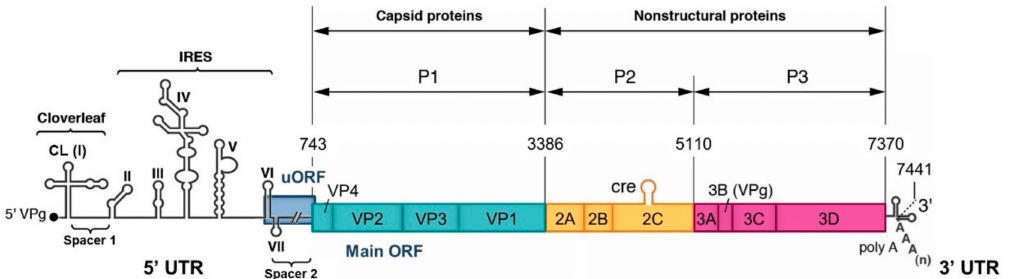
Figure 1. Organization of the genome of poliovirus type 1 (PV1) Mahoney. The poly-adenylated single positive-strand RNA genome is covalently linked to the viral protein VPg (also named 3B) at the 5 (cid:48) terminus. In addition to the main large open-reading frame (ORF), the majority of the EV-A, EV-B and EV-C genomes, and in particular PV1 genome, contain a second upstream overlapping ORF (uORF). However, PV2 and PV3 genomes do not contain an intact uORF. The coding region is flanked by two untranslated regions (5 (cid:48) and 3 (cid:48) UTRs). The 5 (cid:48) UTR (nucleotides 1 to 743) is magnified to indicate the seven stem-loop structures (I to VII) forming two functional units, the cloverleaf (CL: I) and the internal ribosome entry site (IRES: II-VI). The P1 region encodes the capsid proteins (VP1-4) and the P2 and P3 regions encode the non-structural proteins such as the RNA-dependent RNA polymerase